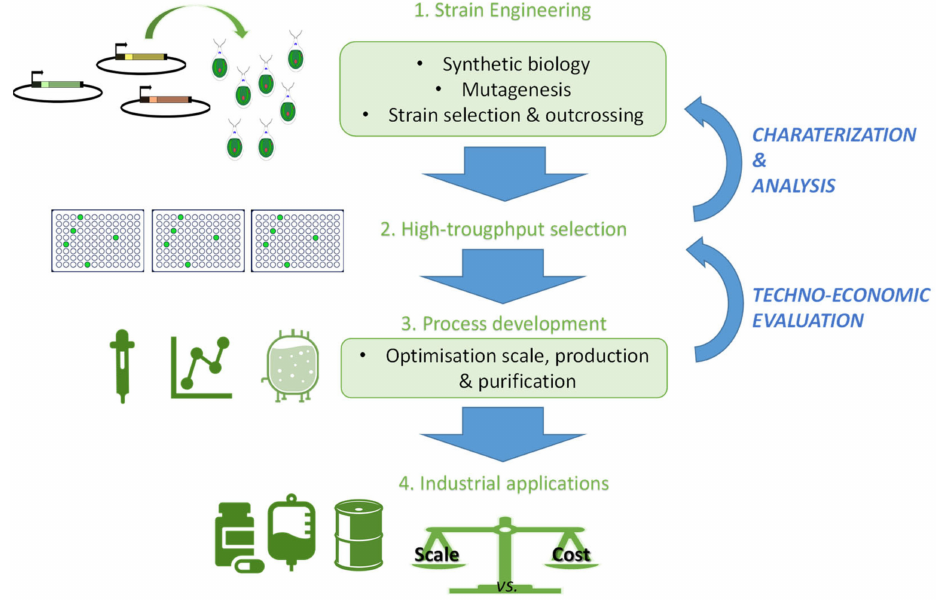
Figure 3. The key steps in bioengineered green algae production (adapted from Scranton et al.